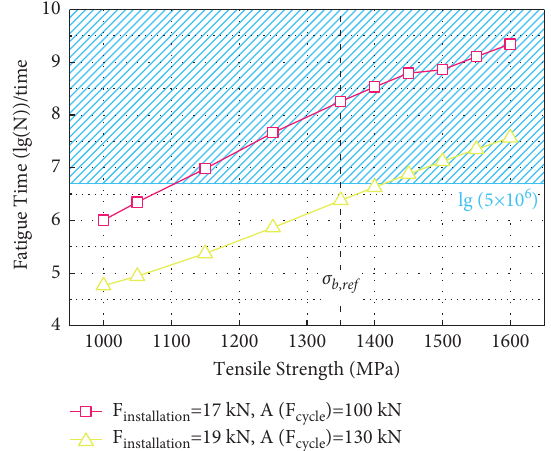
Figure 14: Variations in the fastening clip fatigue life with elastic modulus of the material.